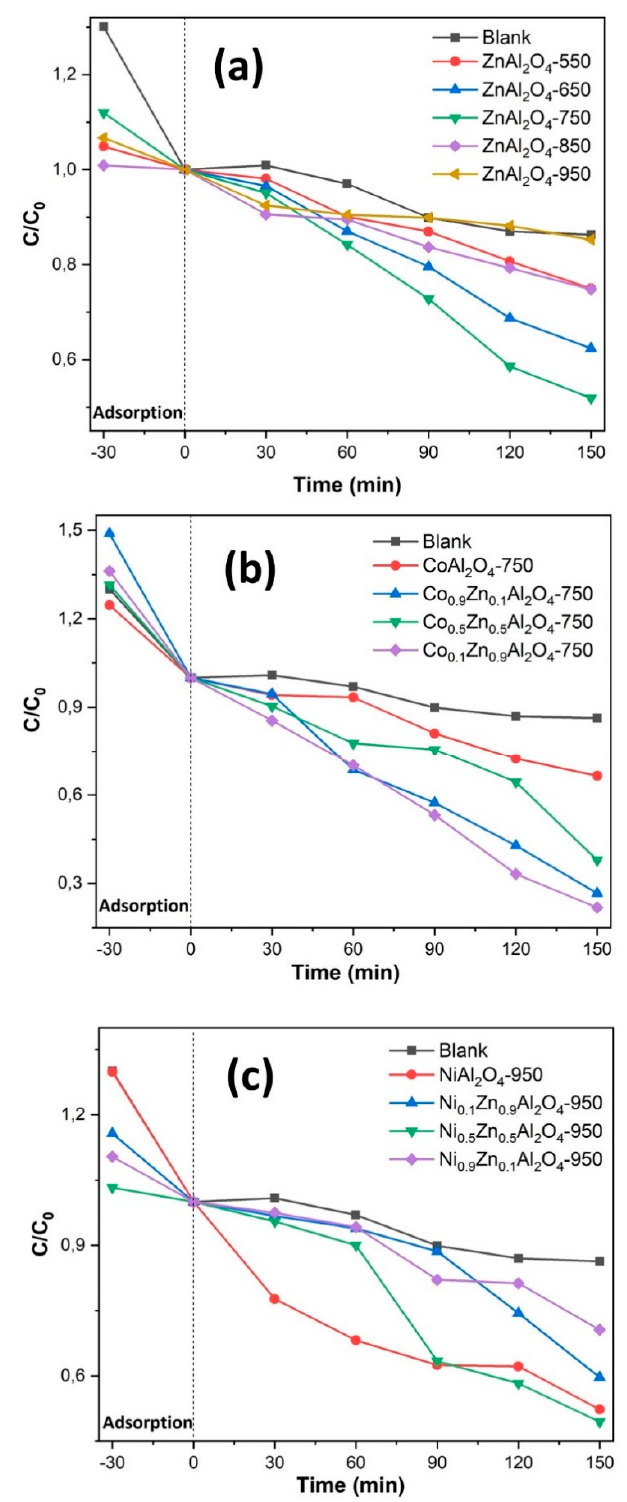
Figure 7. Rhodamine B photocatalytic degradation test for samples: ZnAl 2 O 4 –550, ZnAl 2 O 4 –650,